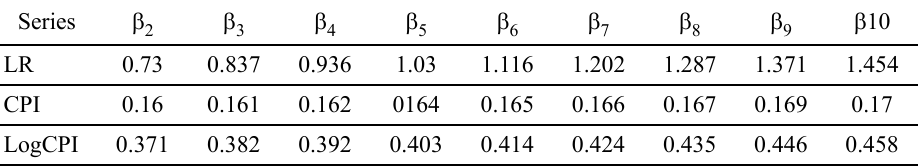
(null of iid rejected at 1% level) m